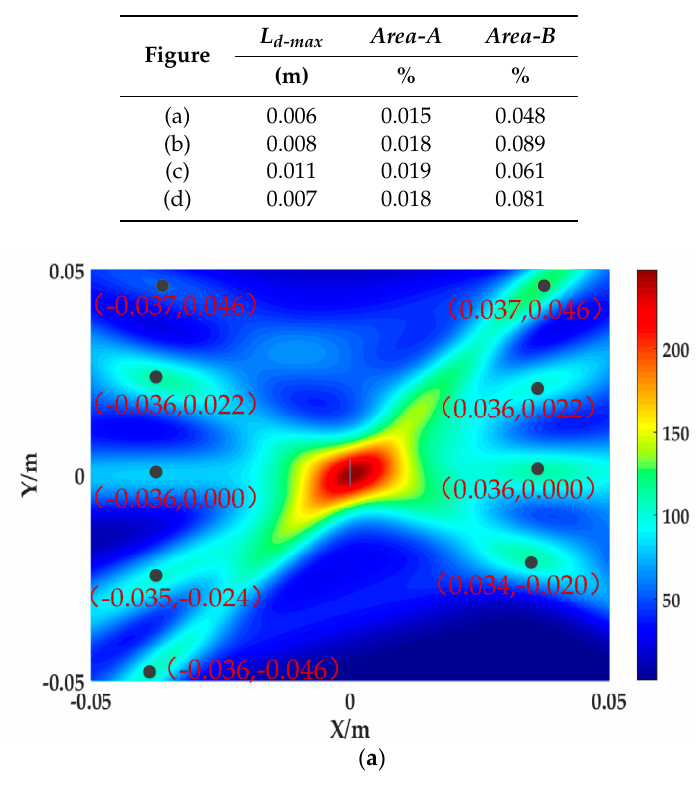
Table 2. Parameters used to evaluate the results of Figure 11.